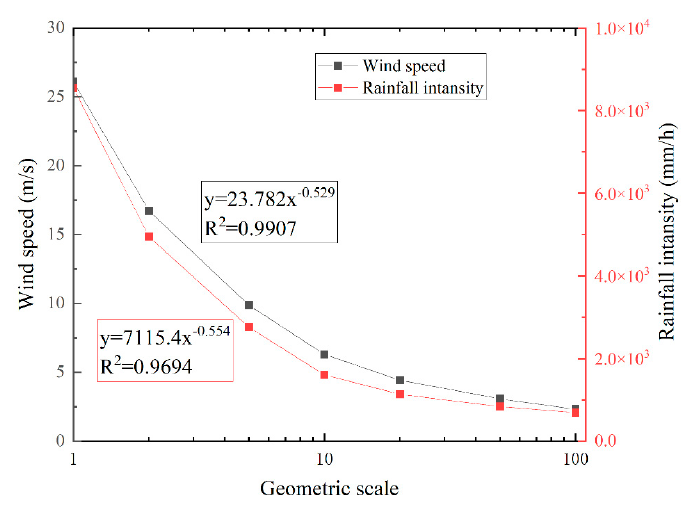
Figure 14. Model atomization rainfall and atomization wind speed under different geometric scale conditions. The conversion relationship coefficient n between the model and prototype with dif- ferent geometric scale values is solved by using the prototype observation values of the maximum atomization wind speed and rainfall measurement points, as shown in Table 2.